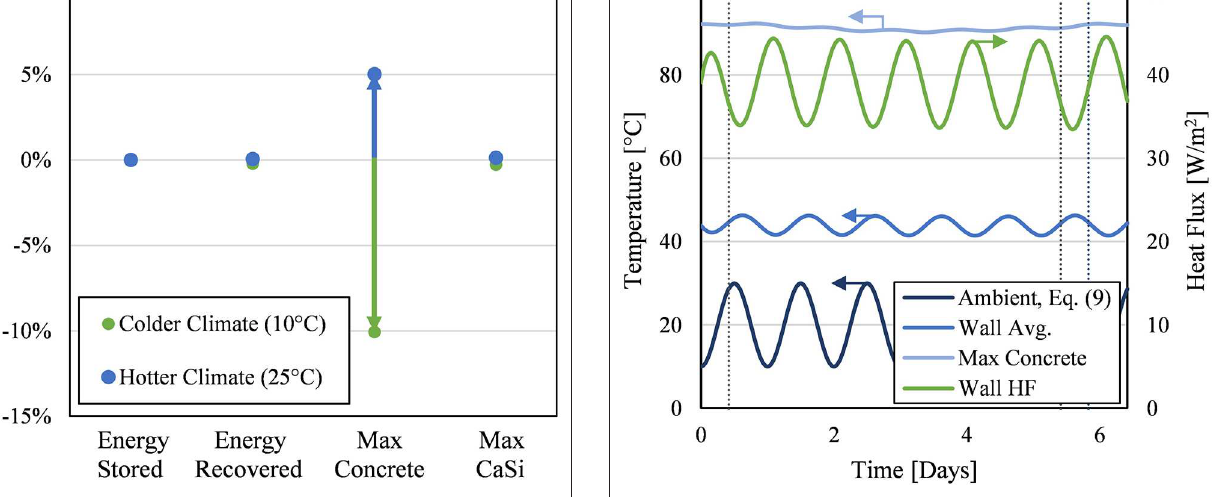
at the end of the storage cycle was unchanged from 1181.7 ◦